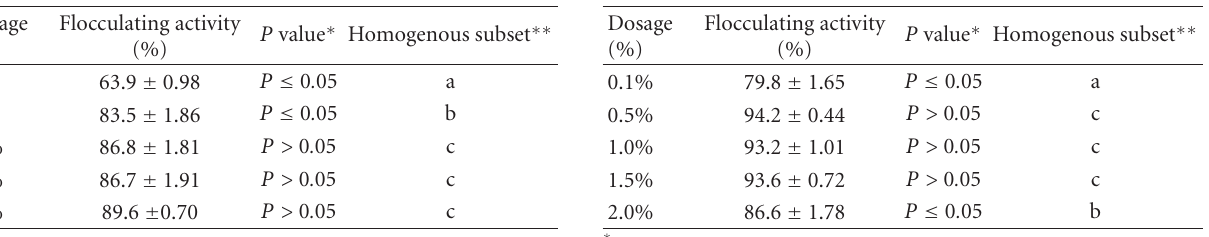
Table 3: Statistical analysis for flocculating activity at 0–20% cation dosage.